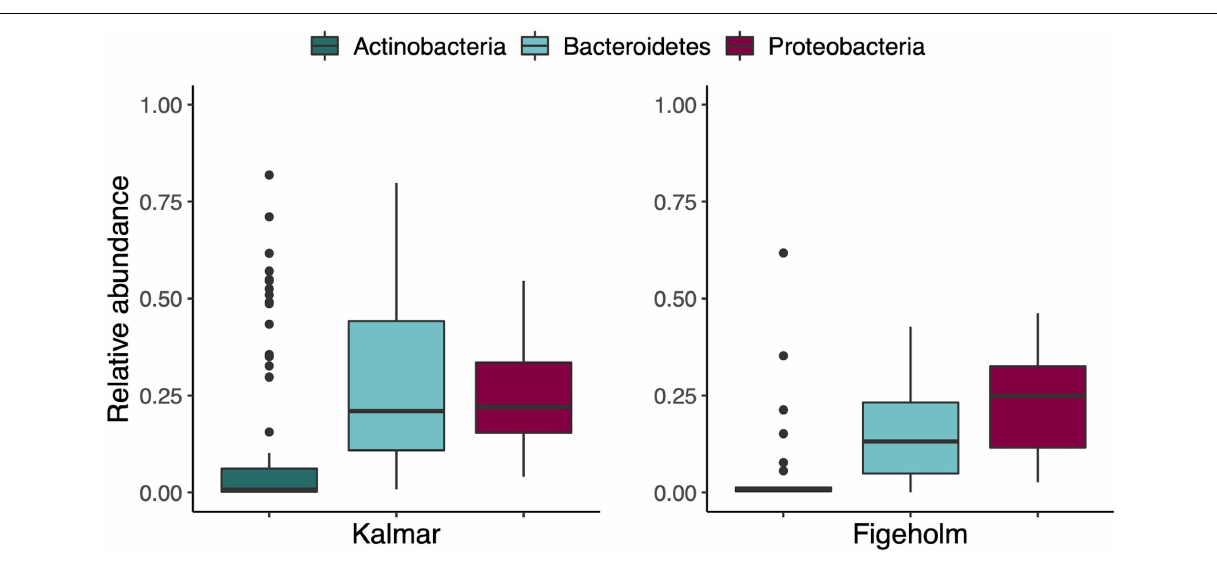
FIGURE 4 | Relative abundance of the three most prevalent phyla among all microbiome samples, split by population. Boxplot elements: center line, median; box limits, upper and lower quartiles; whiskers, 1.5 × interquartile range. Each dot represents a